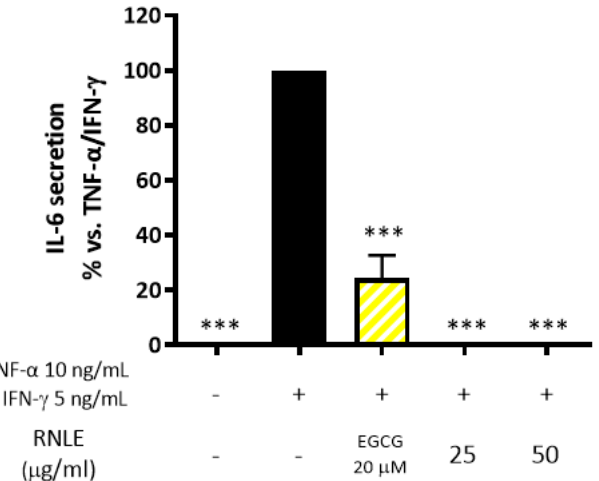
Figure 6. Effect of RNLE treatment (25–50 µ g/mL) on IL-6 secretion in HaCaT cells stimulated with a combination of IFN- γ and TNF- α (5 ng/mL + 10 ng/mL, 24 h); the amount of IL-6 in the stimulated condition was 118.66 ± 15.95 pg/mL. ( − )-Epigallocatechin 3-gallate (EGCG) 20 µ M was used as the reference compound; *** p < 0.001 vs. stimulus.